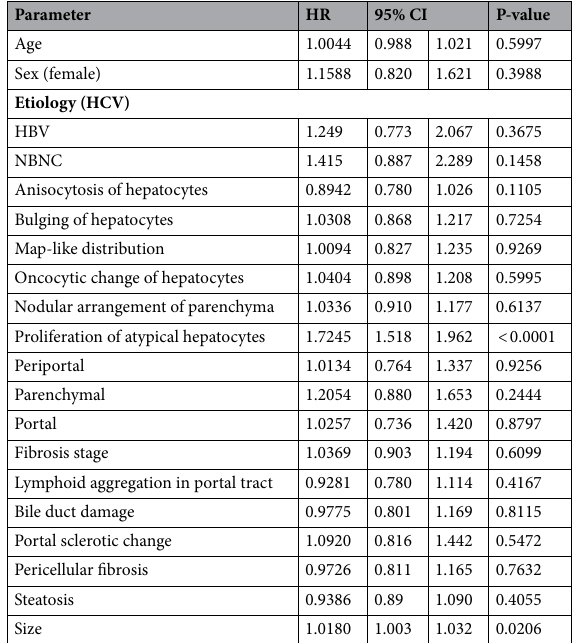
Table 1. Factors affecting postoperative-recurrence in patients with HCC in Cohort 1 by Cox multivariate proportional hazards regression model. (n = 356). Hazard ratio (HR) was calculated using the Cox multivariate proportional hazards regression model. Peri-venular fibrosis in the subjects of F3 and F4 stages, was excluded from the factor because there were many undetectable in hematoxylin and eosin section. HCV, patients with hepatitis c virus antibody-positive; HBV, patients with hepatitis B virus surface antigen-positive; NBNC, patients with both